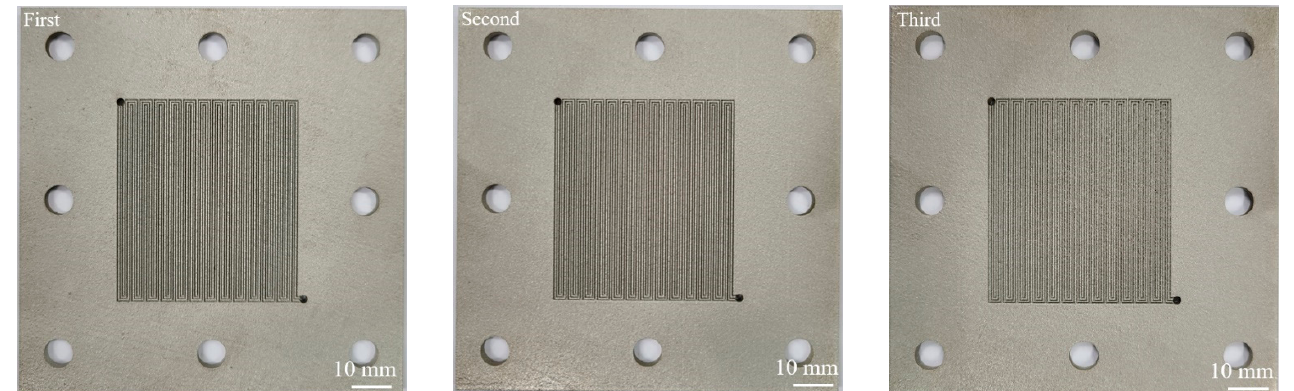
Figure 6. Planar view of PBF-built SUS 316L BPs with a thickness of 2 mm.